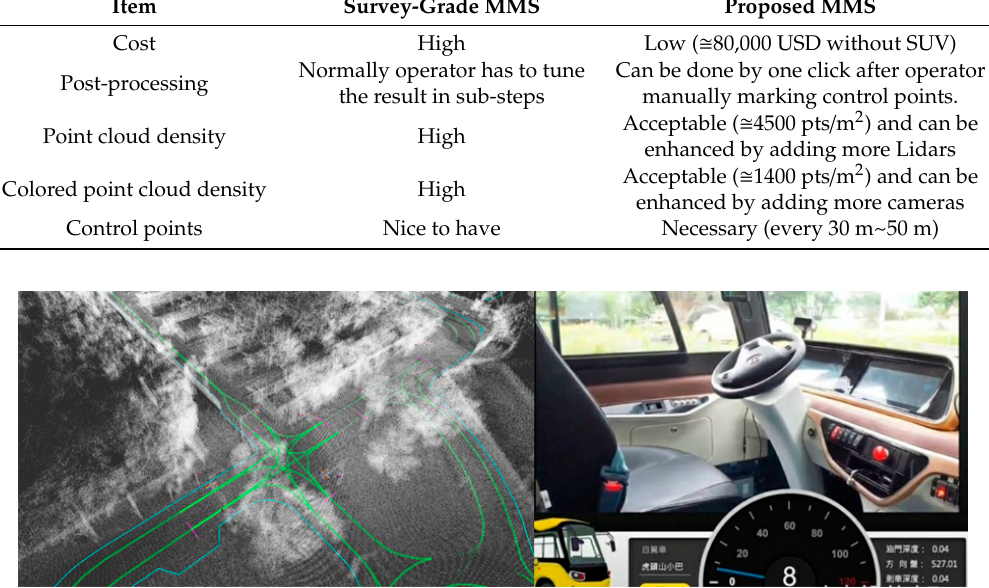
Table 1. Comparison between survey-grade MMS and the proposed MMS.